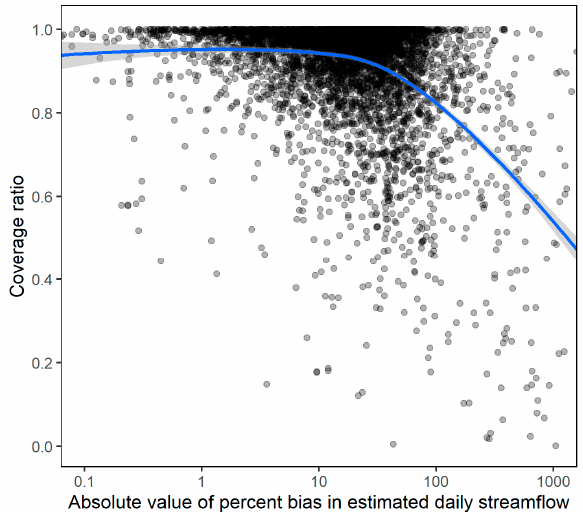
Figure 5. Absolute value of the percentage bias of daily streamflow time series and the coverage ratio associated with 95 percent uncertainty intervals of the streamflow time series. Blue line is a smoothed conditional mean.